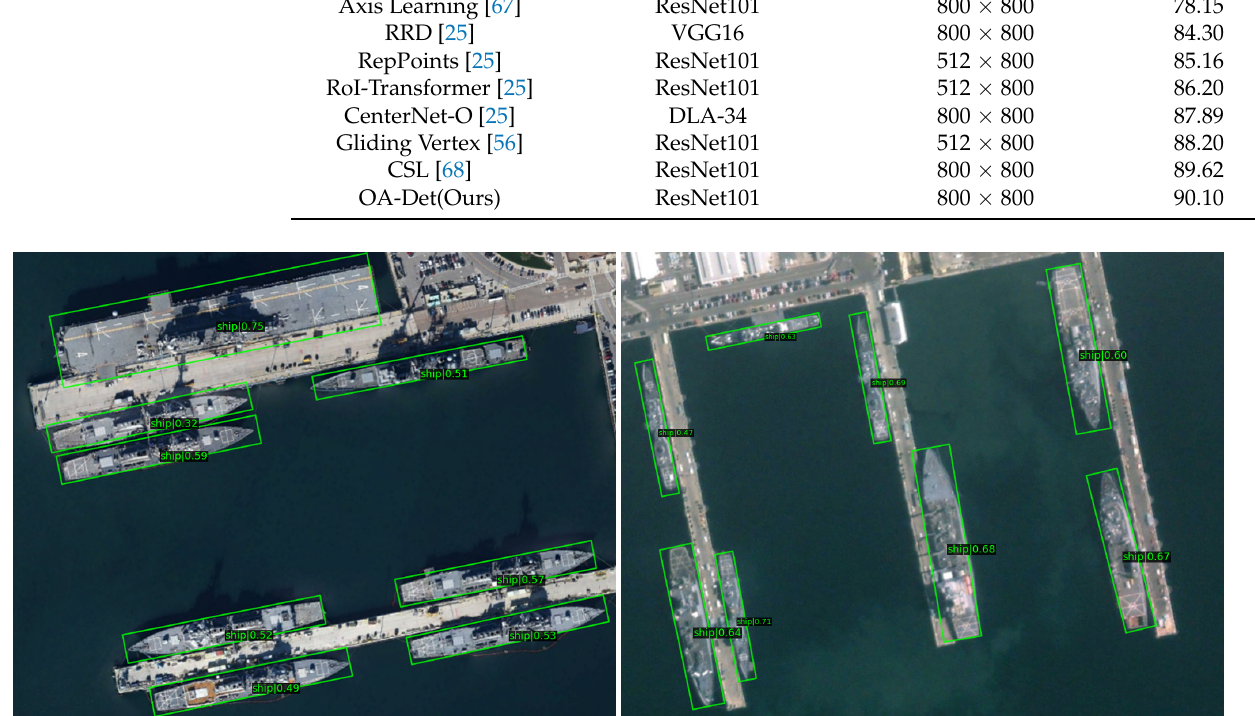
Figure 9. Visualization of predictions on the HRSC2016 dataset using our OA-Det method.